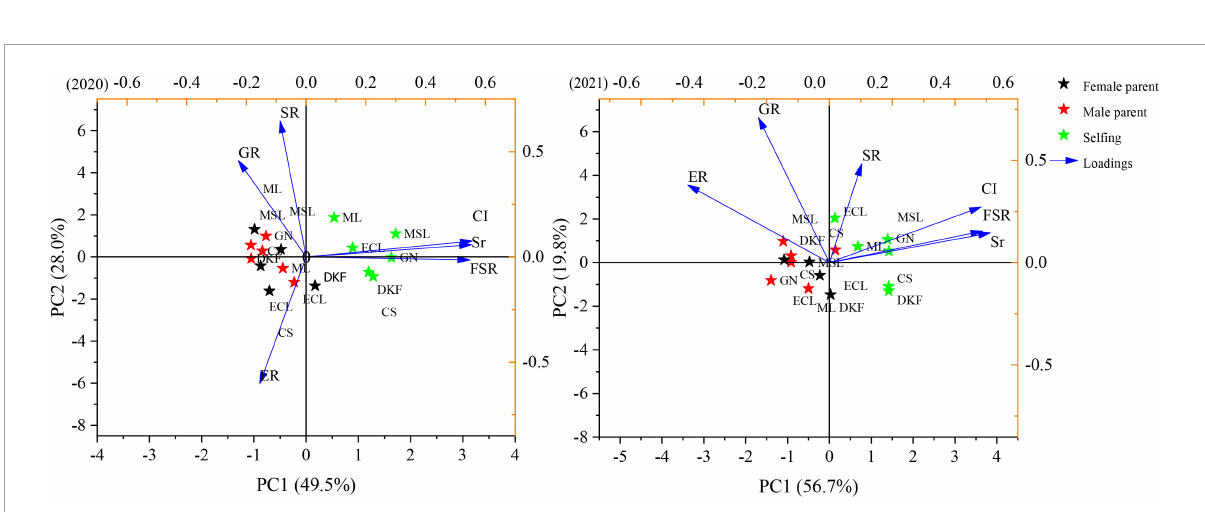
FIGURE3 Principal component analysis of fertility indexes in 2020–2021. FSR, Sr, CI, GR, ER, and SR represent fertility indexes of fruit-setting rate, seediness rate, compatibility index, germination rate, emergence rate, and seedling